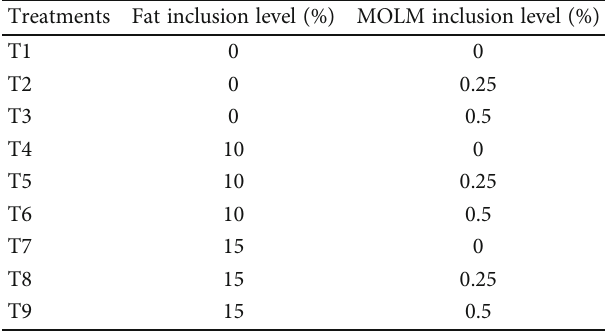
Table 1: Droëwors treatments prepared with di ff erent combinations of fat and